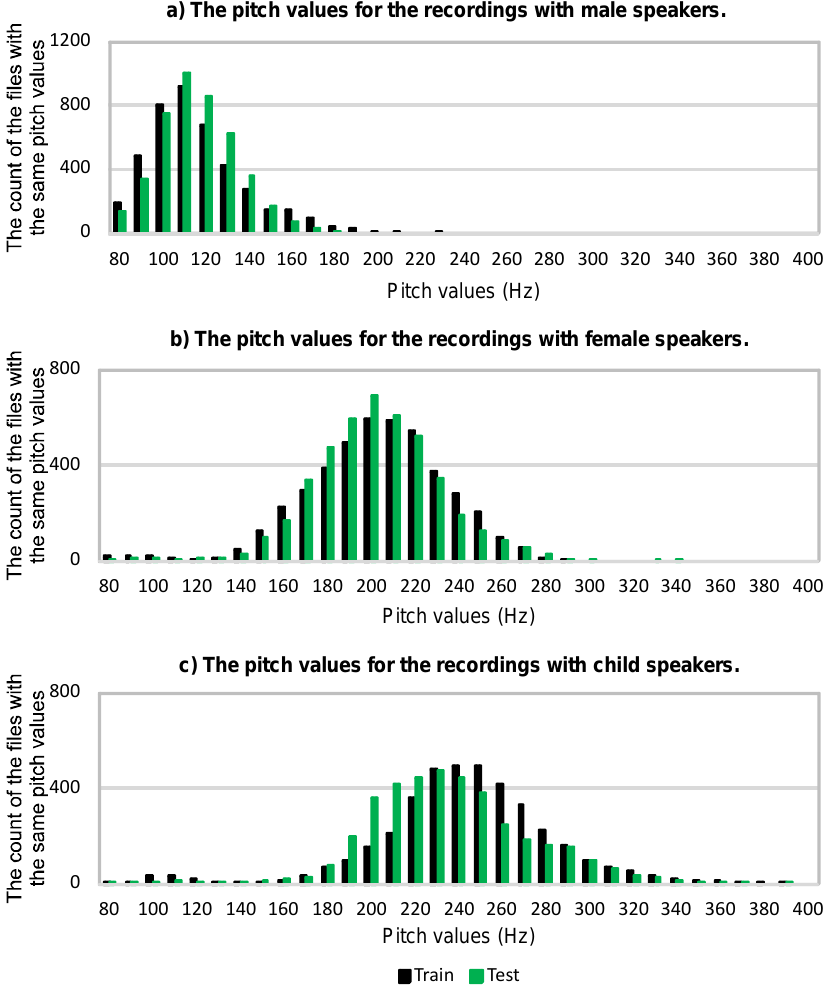
Figure 6. The count of the files with the same pitch values for the recordings with ( a ) male, ( b ) female, and ( c ) child speakers.